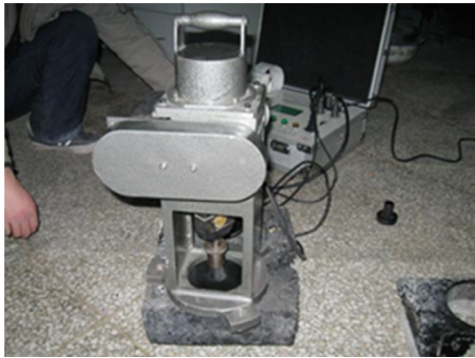
Figure 7. Pull-off test instrument.